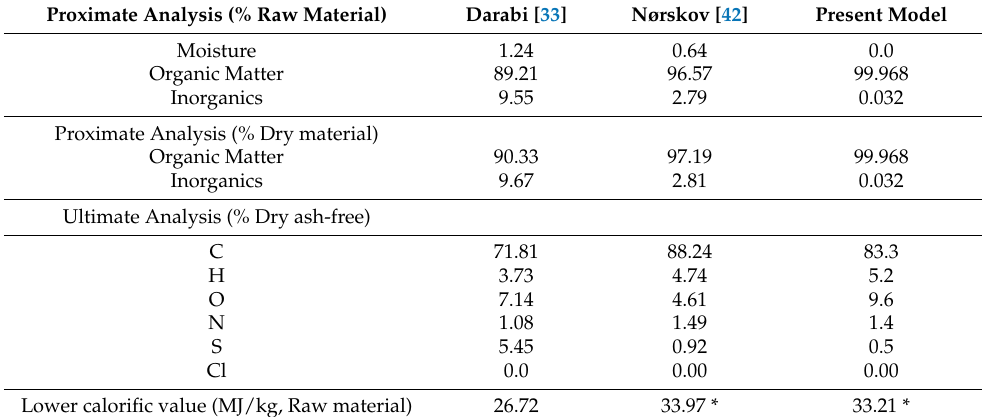
Table 7. Proximate and ultimate analyses of the heavy fuel oil used in the area of